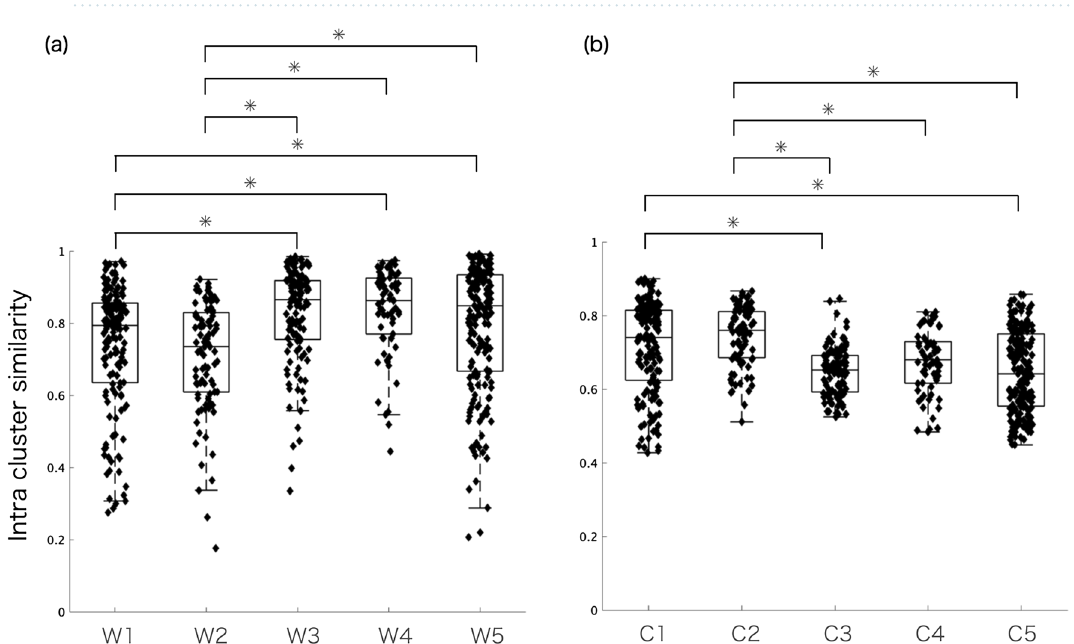
Figure 6. Intra-cluster similarity of ( a ) muscle synergies (W1–W5) and ( b ) temporal patterns (C2–C5). Kruskal–Wallis test showed p < 0.05 for both W and C. Multiple comparisons show statistically significant differences between W and C as follows: W1 and W3, W1 and W4, W1 and W5, W2 and W3, W2 and W4, and W2 and W5 (p < 0.05). C1 and C3, C1 and C5, C2 and C3, C2 and C4, and C2 and C5 (p <